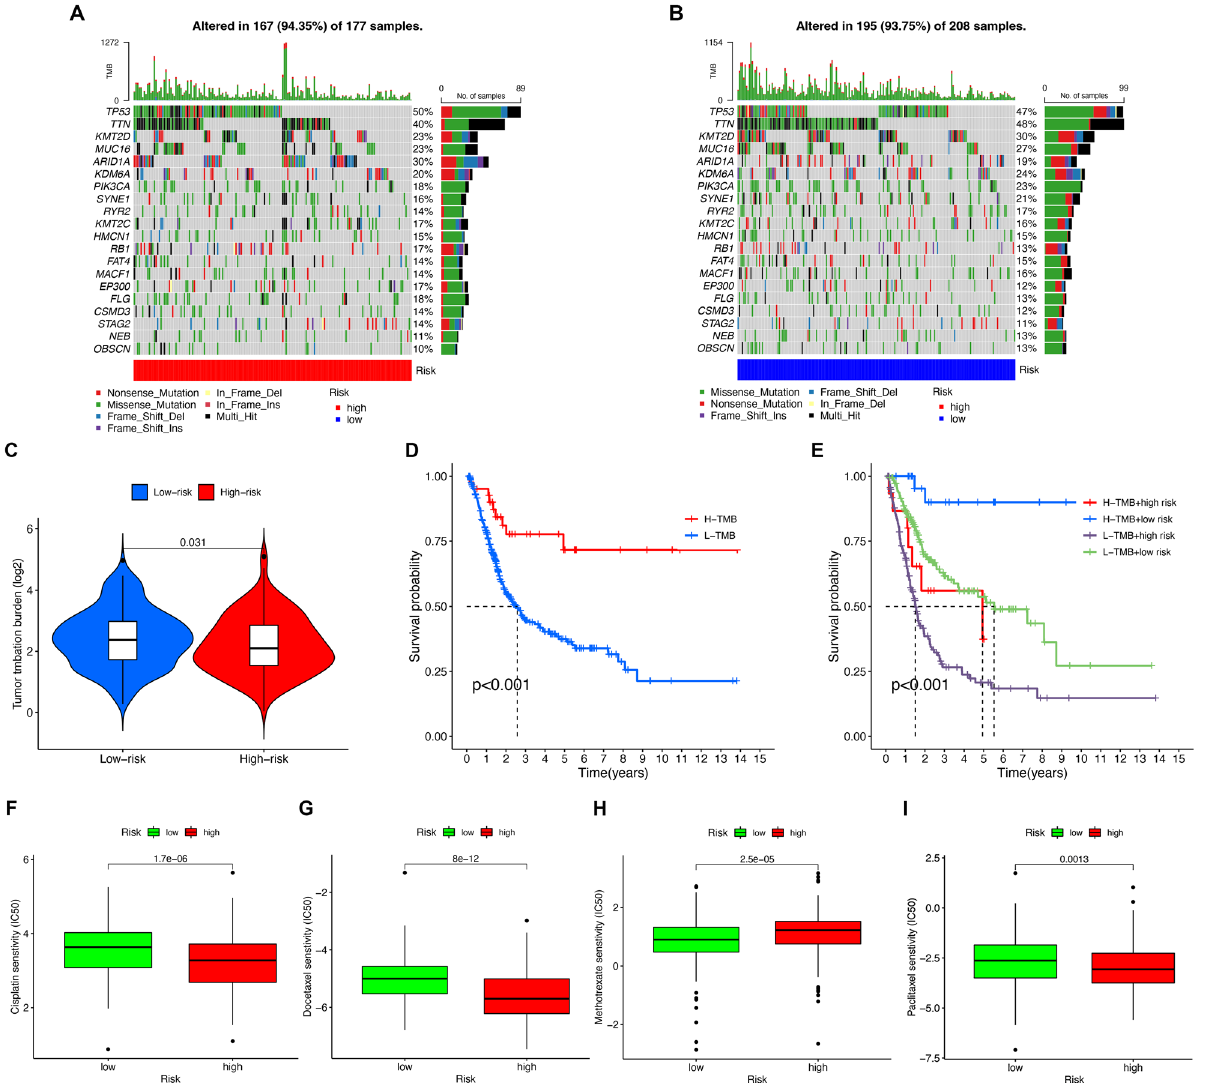
Figure 8. Tumour mutational burden (TMB) and Drug susceptibility analysis. ( A ) The waterfall chart of the frequently mutated genes in the high-risk group. ( B ) The waterfall chart of the frequently mutated genes in the low-risk group. ( C ) The relation of TMB and different risk scores. ( D ) Kaplan–Meier curves of high- and low-TMB on OS. ( E ) Kaplan–Meier curves of TMB and risk score on OS. ( F – I ) Treatment effects of cisplatin, docetaxel, methotrexate and paclitaxel were evaluated in patients with high- and low-risk